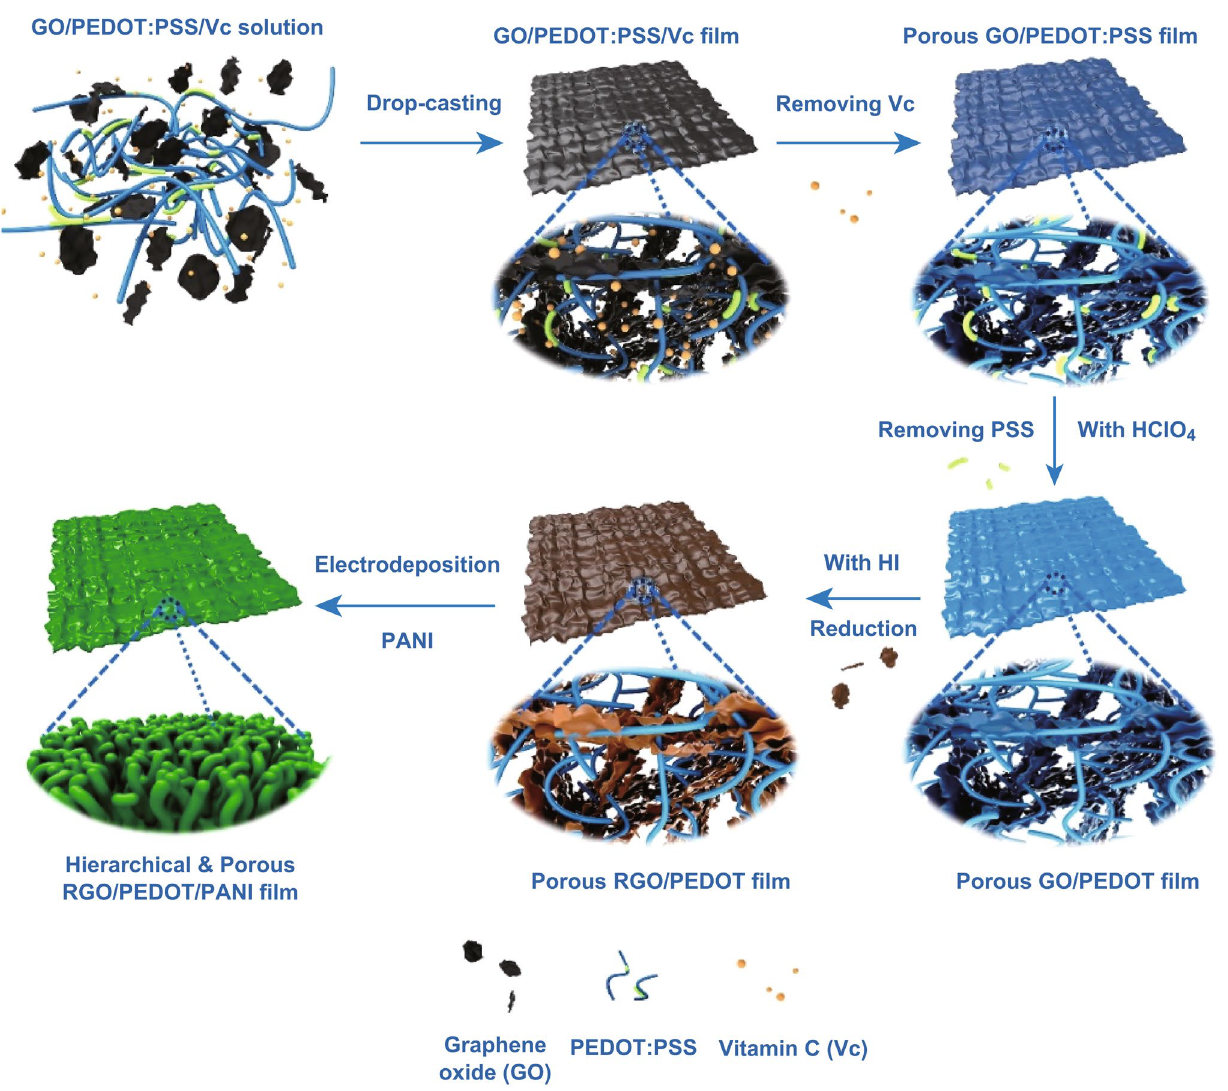
Fig. 1 Fabrication process of hierarchical and porous RGO/PEDOT/PANI